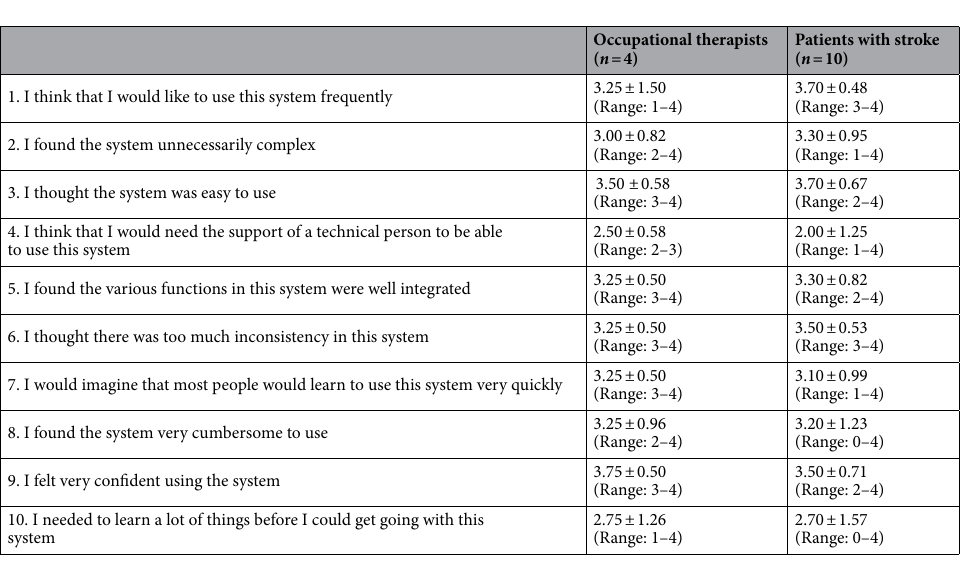
Table 4. Mean ratings on each item of the System Usability Scale in occupational therapists and patients with stroke. The listed statistics are mean ± standard deviation (SD). Note: The transformed score of each item is ranged from 0 to 4. For the odd- and even-numbered items, higher scores are indicative of higher and lower agreement with the statement of the item,